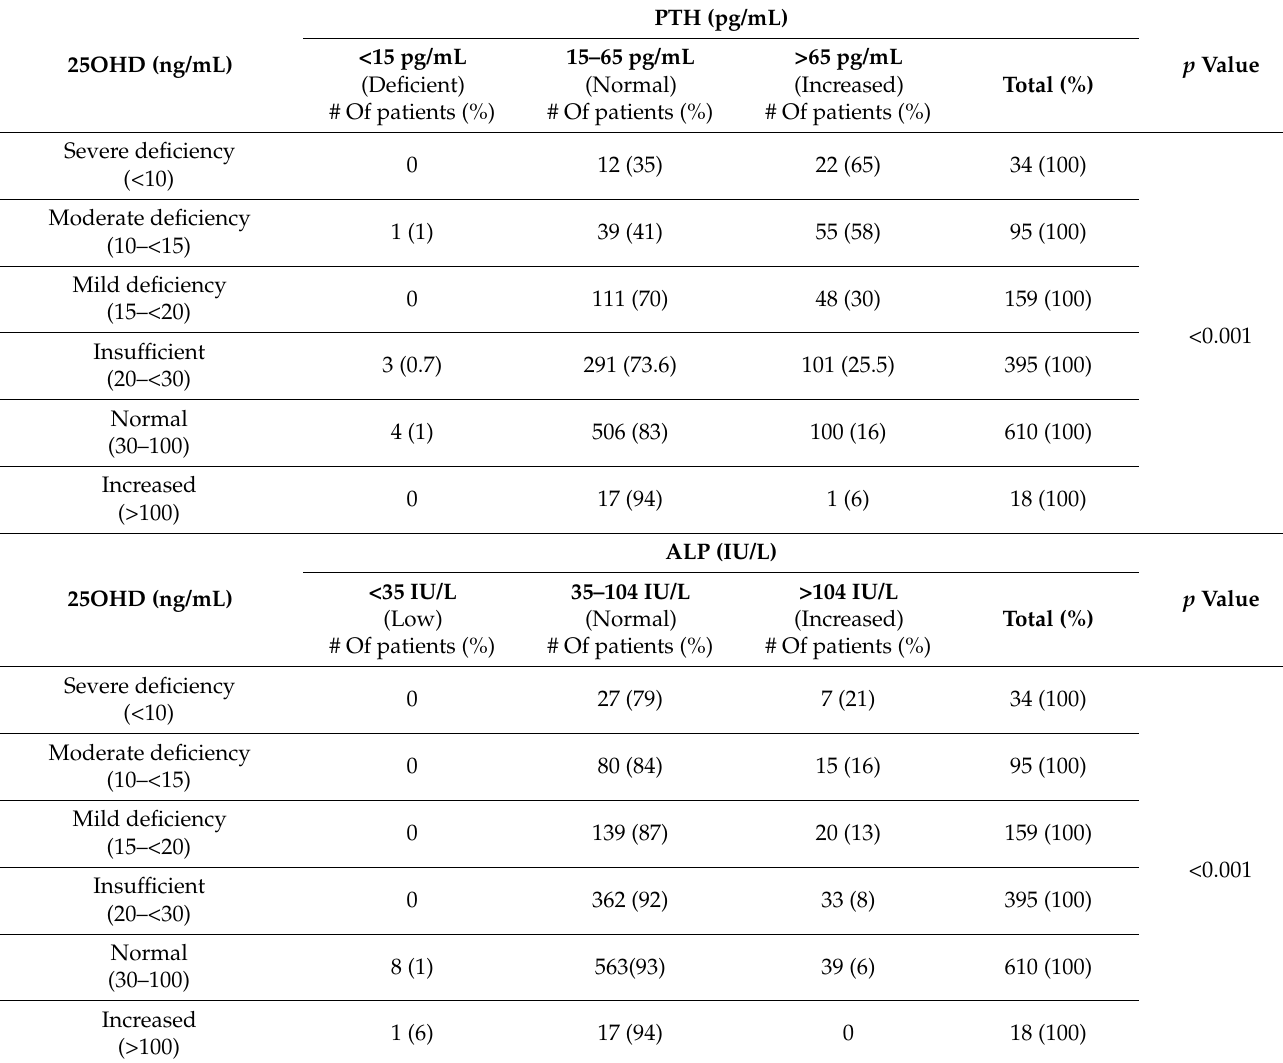
Table 3. Association between vitamin D and PTH and ALK ( n =